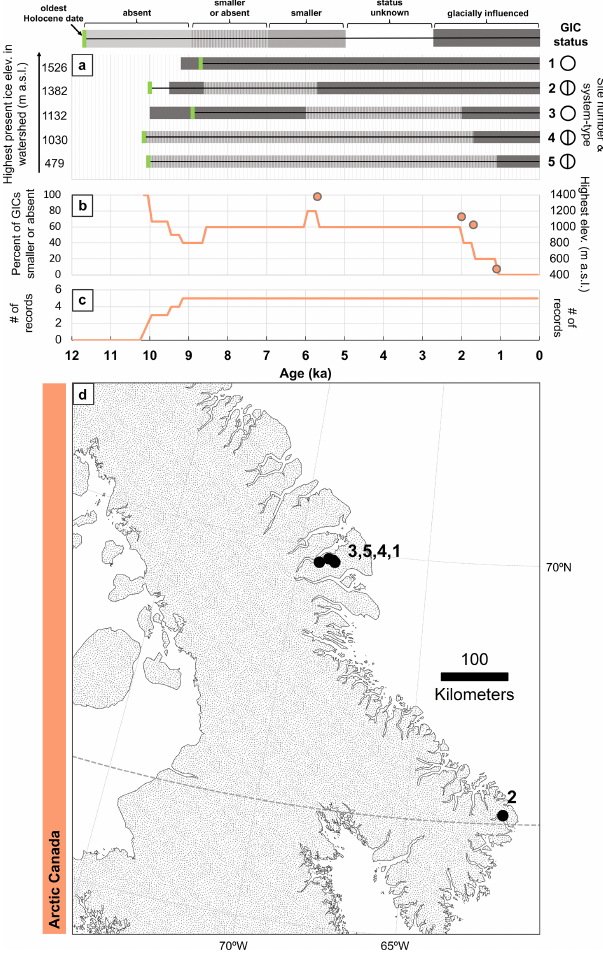
Figure 4. Holocene lake-based GIC records from Arctic Canada (Baffin Island, northeastern Canada). Panel descriptions, symbols, and colors are the same as in Fig. 3. Sites are as follows: 1. Thomas et al. (2010) (Longspur Lake, unnamed glaciers); 2. Moore et al. (2001), Miller et al. (2005) (Donard Lake, Caribou Glacier); 3. Thomas et al. (2010) (Big Round Lake, Kuuktannaq Glacier); 4. Thomas et al. (2010) (Yougloo Lake, Kuuktannaq Glacier); 5. Thomas et al. (2010) (Igloo Door Lake, Kuuktannaq Glacier). We note that the oldest radiocarbon age from Donard Lake is pre- Holocene. We report the oldest Holocene